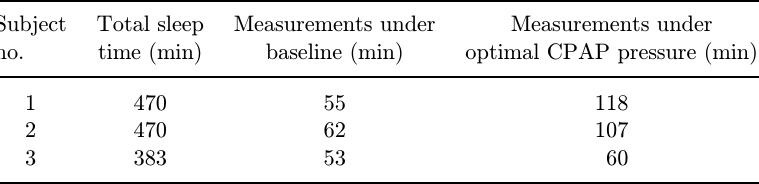
Fig. 3. Typical fragments of cerebral hemodynamics during baseline measurements (a) and optimal CPAP pressures (b) measured from Subject 3. The captions are the same as shown in Fig. 1. Table 2. Sleep information of the three patients during measurements.